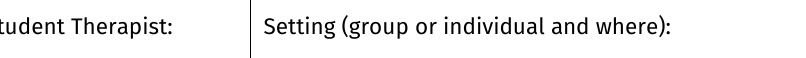
Table 2. ITMT Session